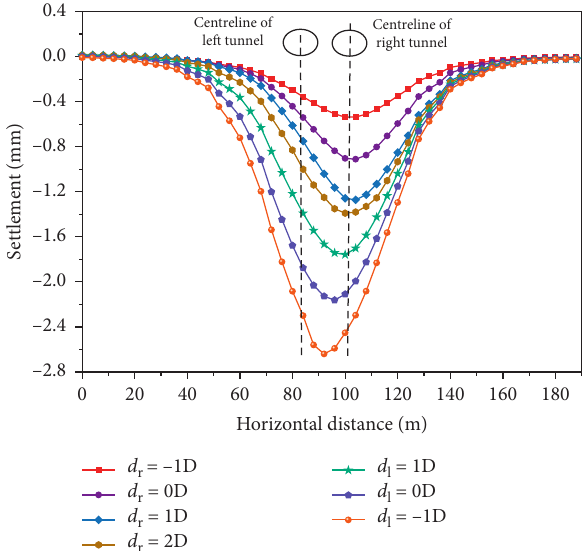
Figure 14: Surface settlement during